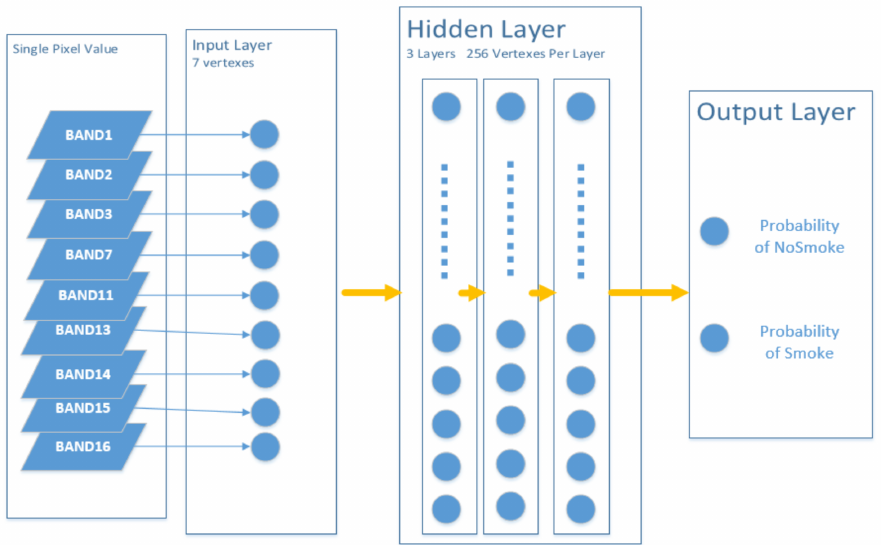
Figure 3. Illustration of the multilayer perceptron. The yellow arrow represents nonlinear func- tions, where the MLP is ReLU(wx+b) , the MLP-BN is BN(ReLU(wx+b)) and the MLP-BN-Dropout is Dropout(BN(ReLU(wx+b))) , where x is the input of the function, w is the weight and b represents